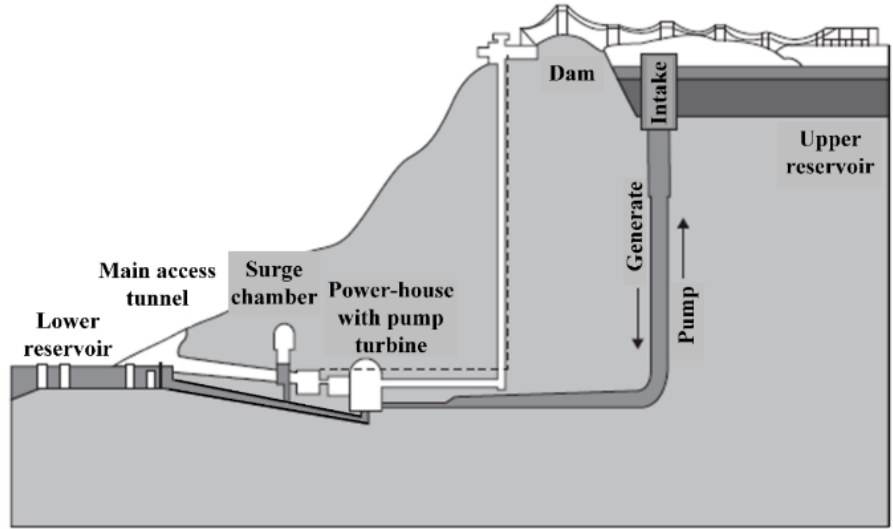
Figure 5. Schematic diagram of a pumped hydro storage system. The potential energy stored by water is converted into electricity at convenient time. [27].